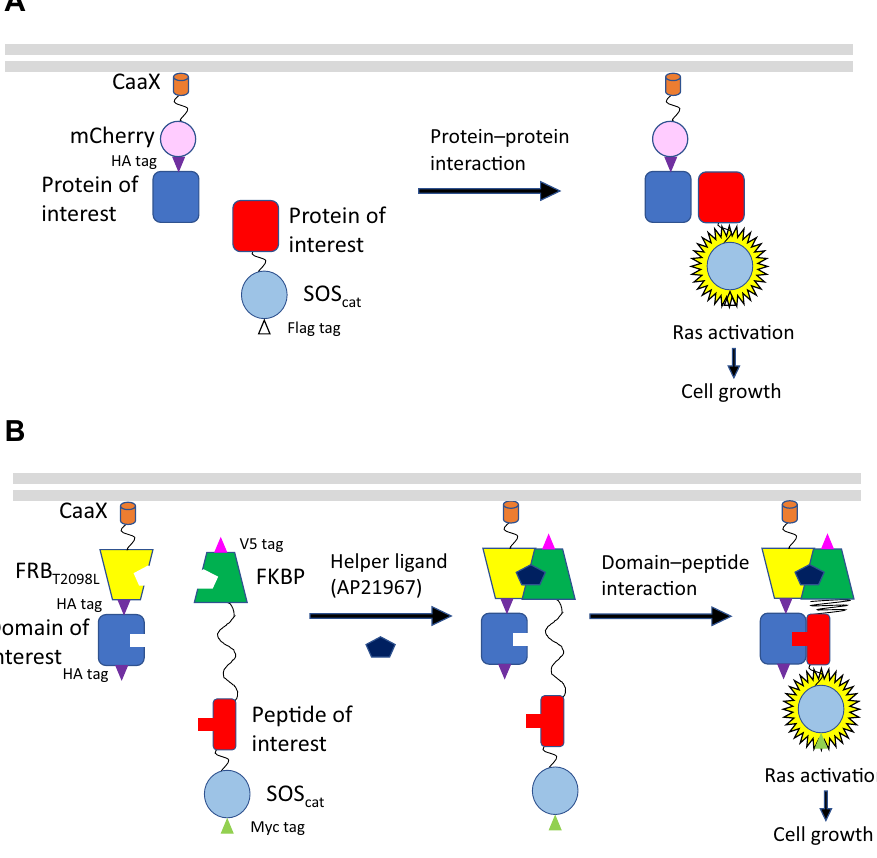
Figure 1. The design and activation mechanism of original SOLIS and H-SOLIS. ( A ) Schematic illustration of original SOLIS. ( B ) Schematic illustration of